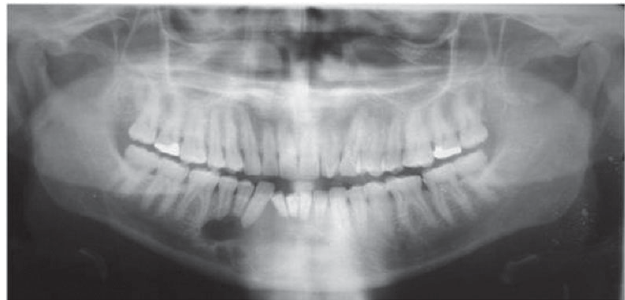
Fig. 5. Photograph showing bicortical expansion on anterior mandible with intact mucosa